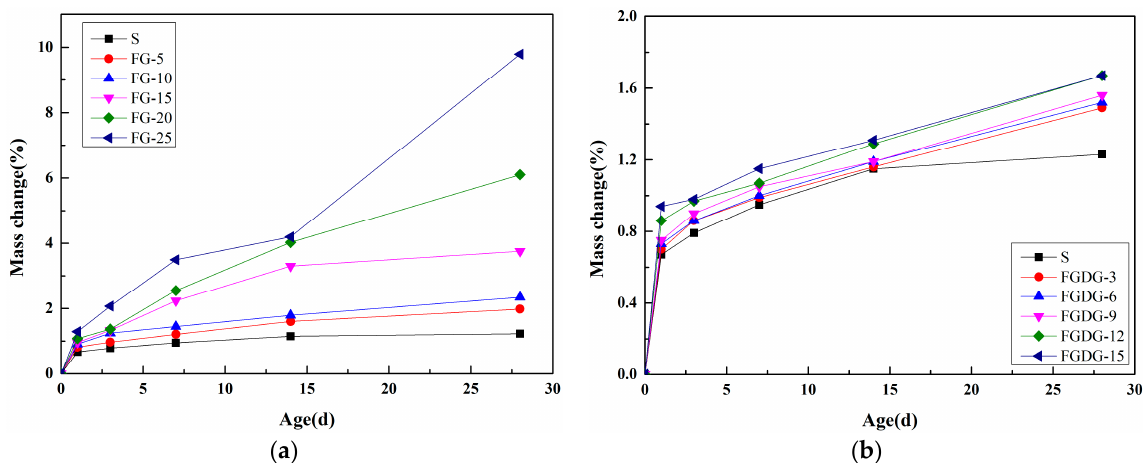
Figure 5. Effect of two types of gypsum on mass change results: ( a ) FG; ( b ) FGDG.